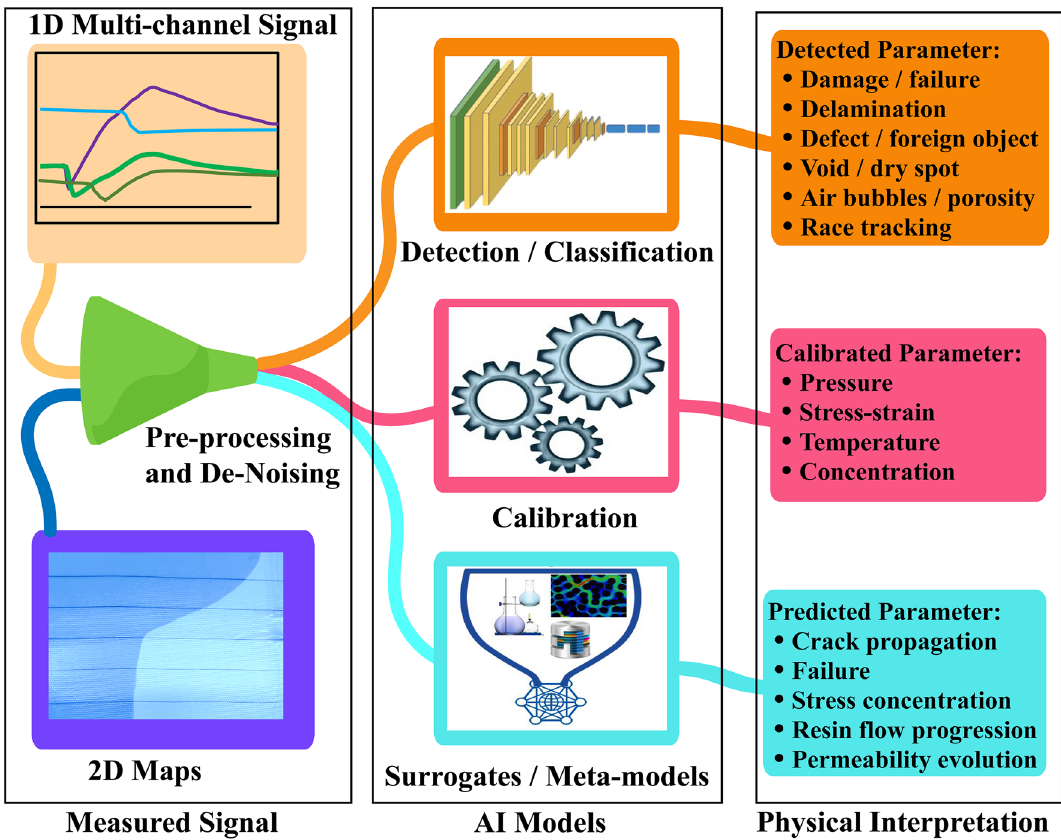
Figure 3. The use of machine and deep learning models for various tasks in composites manufacturing in Industry 4.0. The common application of such models include calibration of the sensors, anomaly detection by analyzing the signals and perform predictive tasks in